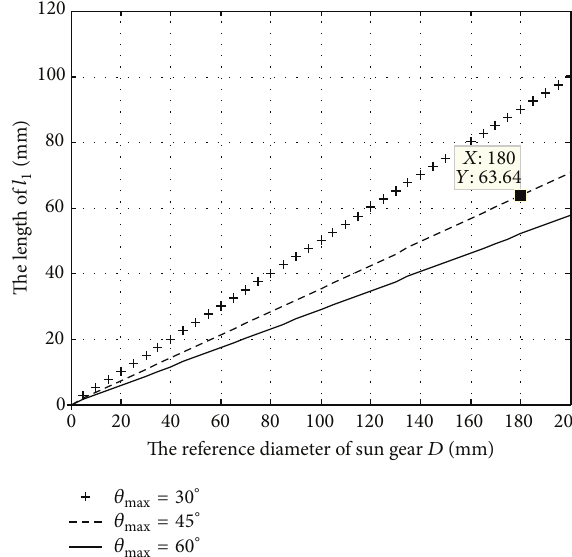
Figure 8: The rod length varies with the reference diameter of the sun gear.